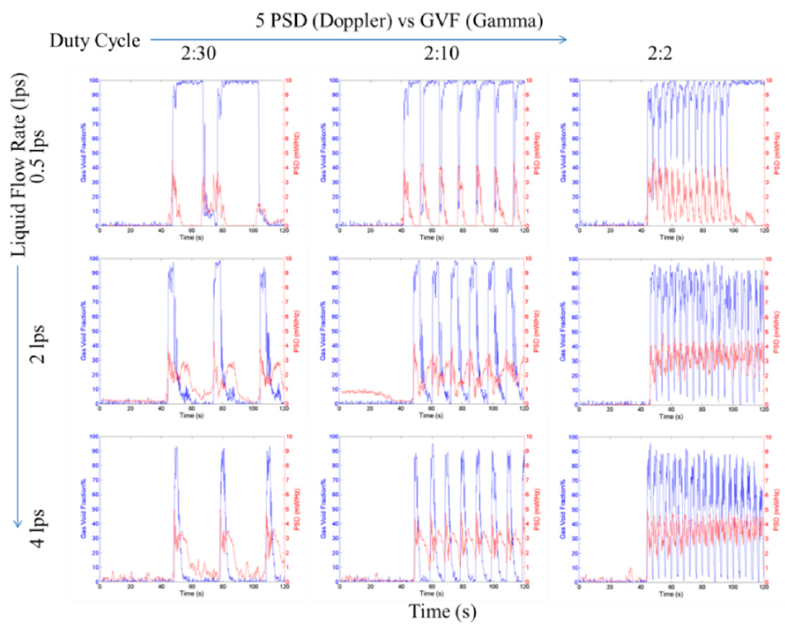
Figure 10. The STFT average power spectral density for various slug trains. The gas void fractions (blue lines) are estimated from the gamma densitometer. The Y-axis limits of each plot in this figure are 0 volts to 1 volt and the X-axis limits are 0 s to 120 s.